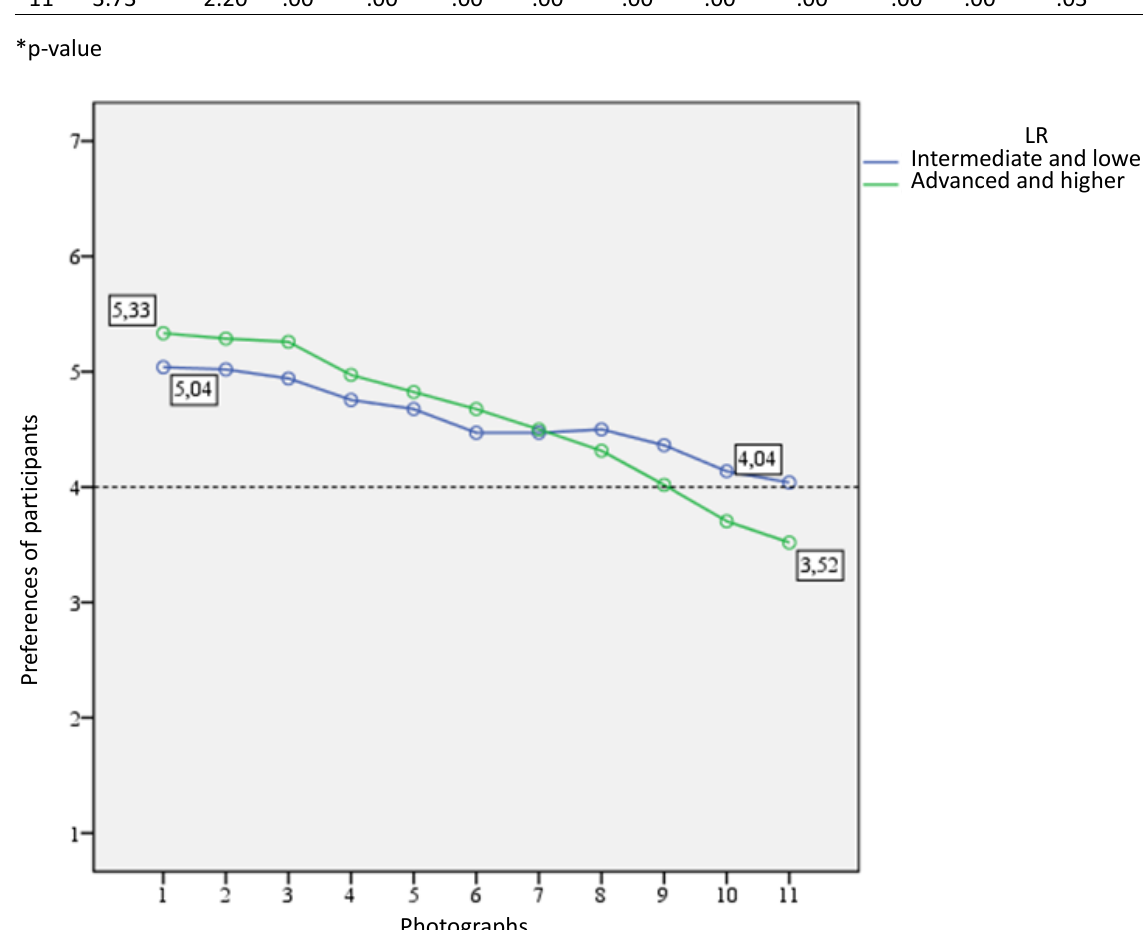
Photographs Figure 4. Curve of climbing willingness of participant according to climber proficiency on the basis of photographs (Chalk density effect)